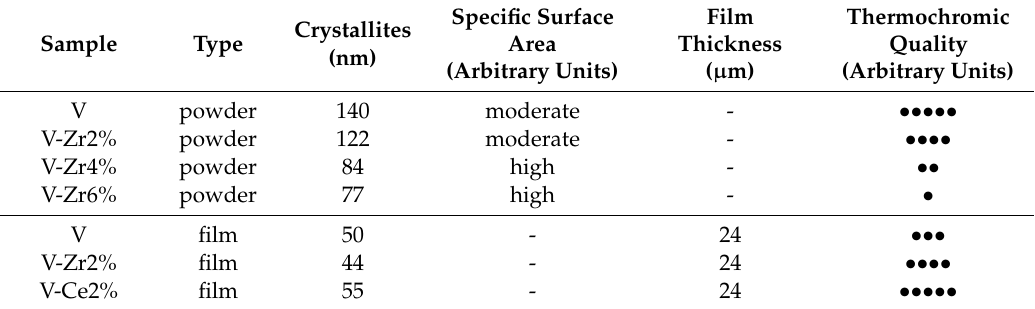
Table 2. Properties of the samples. Thermochromic smart window parameters of all powder samples—pure vanadia and Zr-doped vanadia (2, 4, 6%) (annealed at 400 ◦ C for 5 min)—and film samples—pure vanadia, Zr-doped vanadia (2%) and Ce-doped vanadia (2%) (annealed at 100 ◦ C for 360 min). The amount of “ • ” symbolises an arbitrary unit representing purely empiric